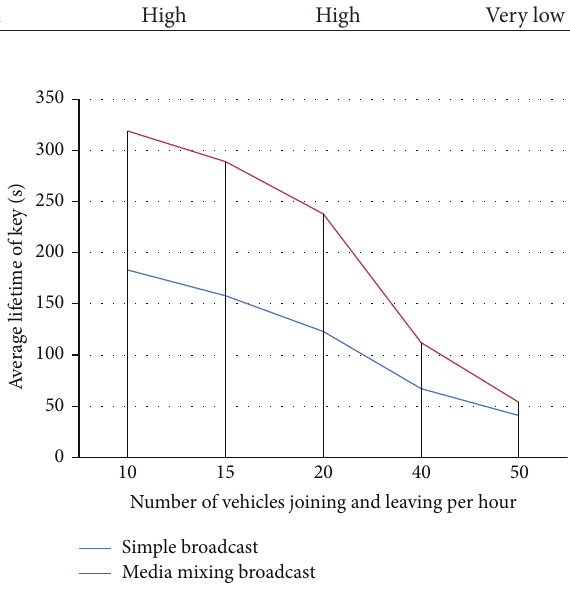
Figure 4: Average lifetime of a